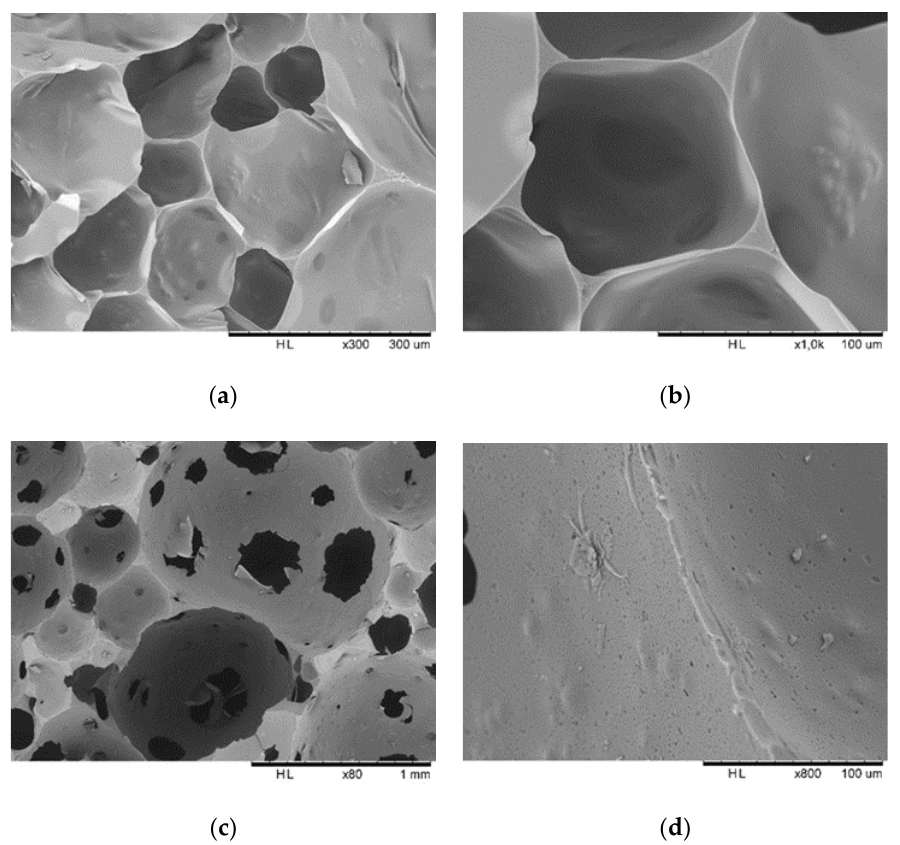
Figure 7. SEM of initial formulation 3 foam with magnitude of ( a ) 300× and ( b ) 10,000×, ambient temperature curing. SEM of initial formulation 4 with magnitude of ( c ) 80× and ( d ) 800×, 80 °C curing.